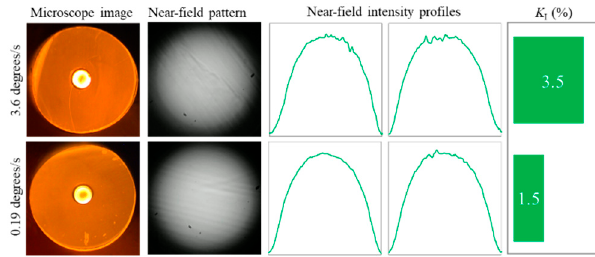
Figure 8. Typical results of cleaves performed at two different speeds with the Wilkinson RB. Cleaving time was 2 s and 28 s. The slowest speed (14 min per cleave) was excluded from the experiments.